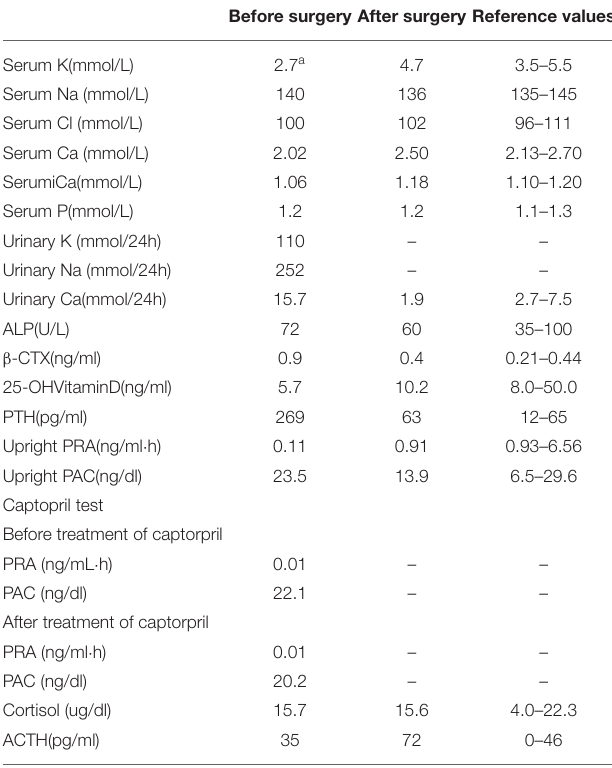
TABLE 1 | Laboratory findings before and after